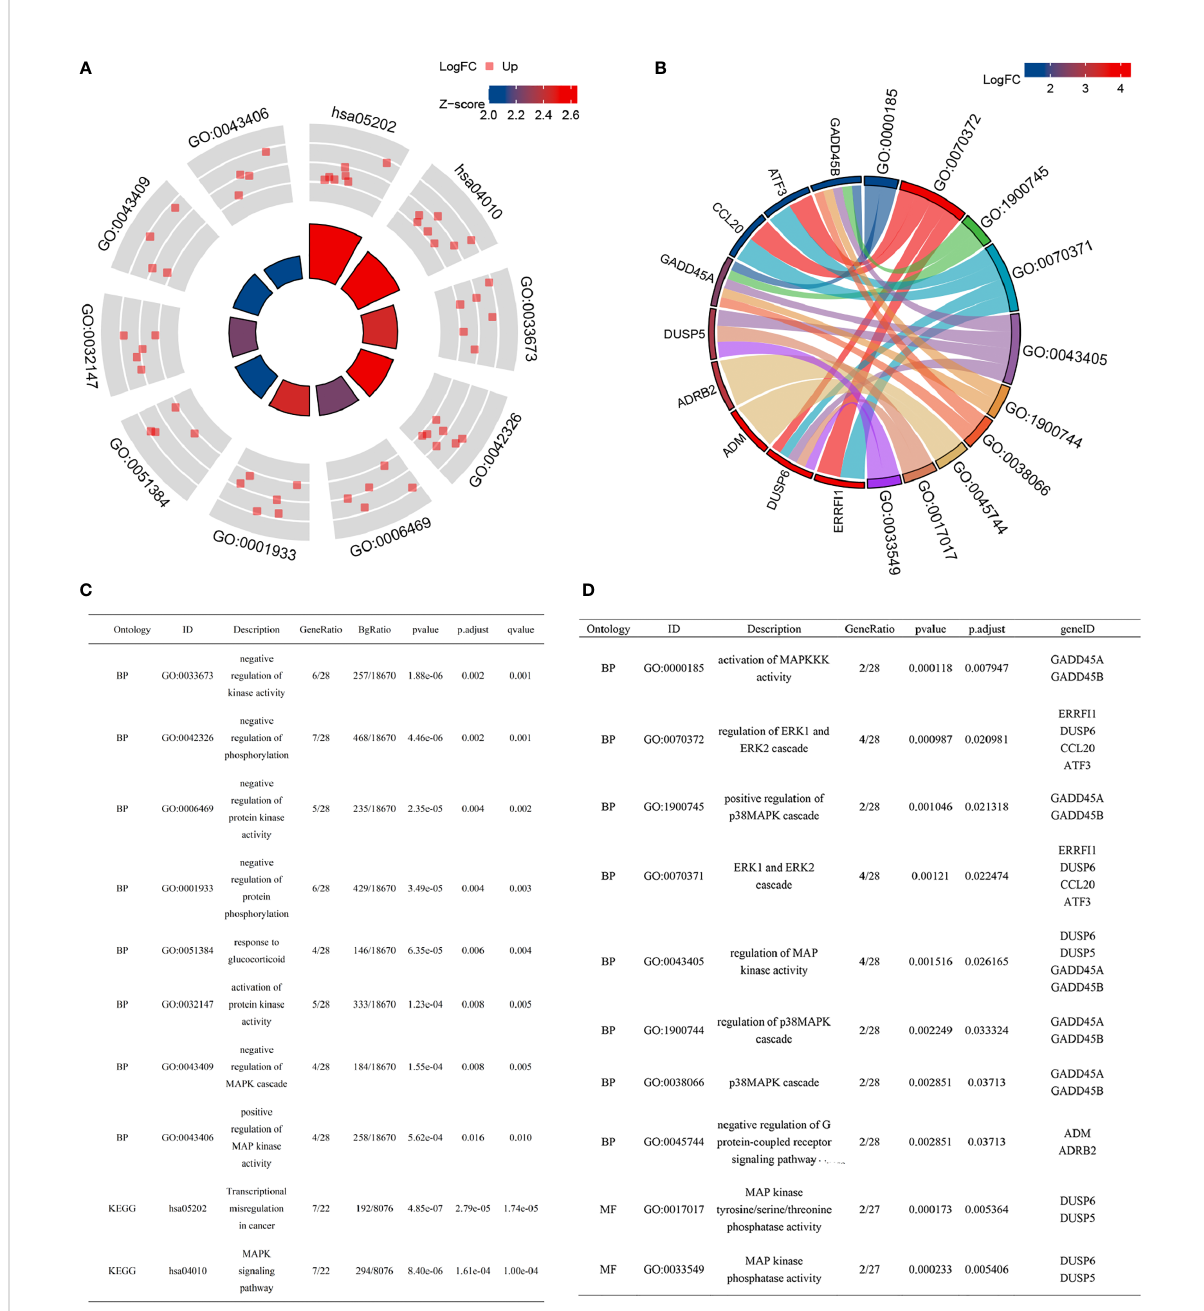
FIGURE 2 GO and KEGG enrichment analysis of 38 cSCC-PDT-related genes. (A) Radar plot of GO and KEGG analysis. (B) A chord gram showing the subordination between genes and the GO terms. (C) The list elaborates on the results of GO and KEGG analysis. (D) GO terms relevant to the MAPK pathway are